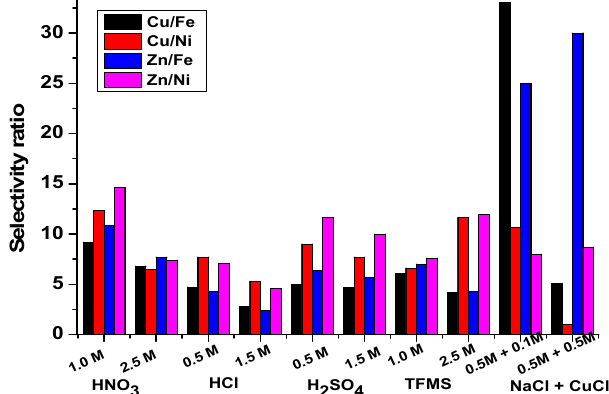
Figure 10. Plot of selectivity ratios for the selected dilute lixiviants.